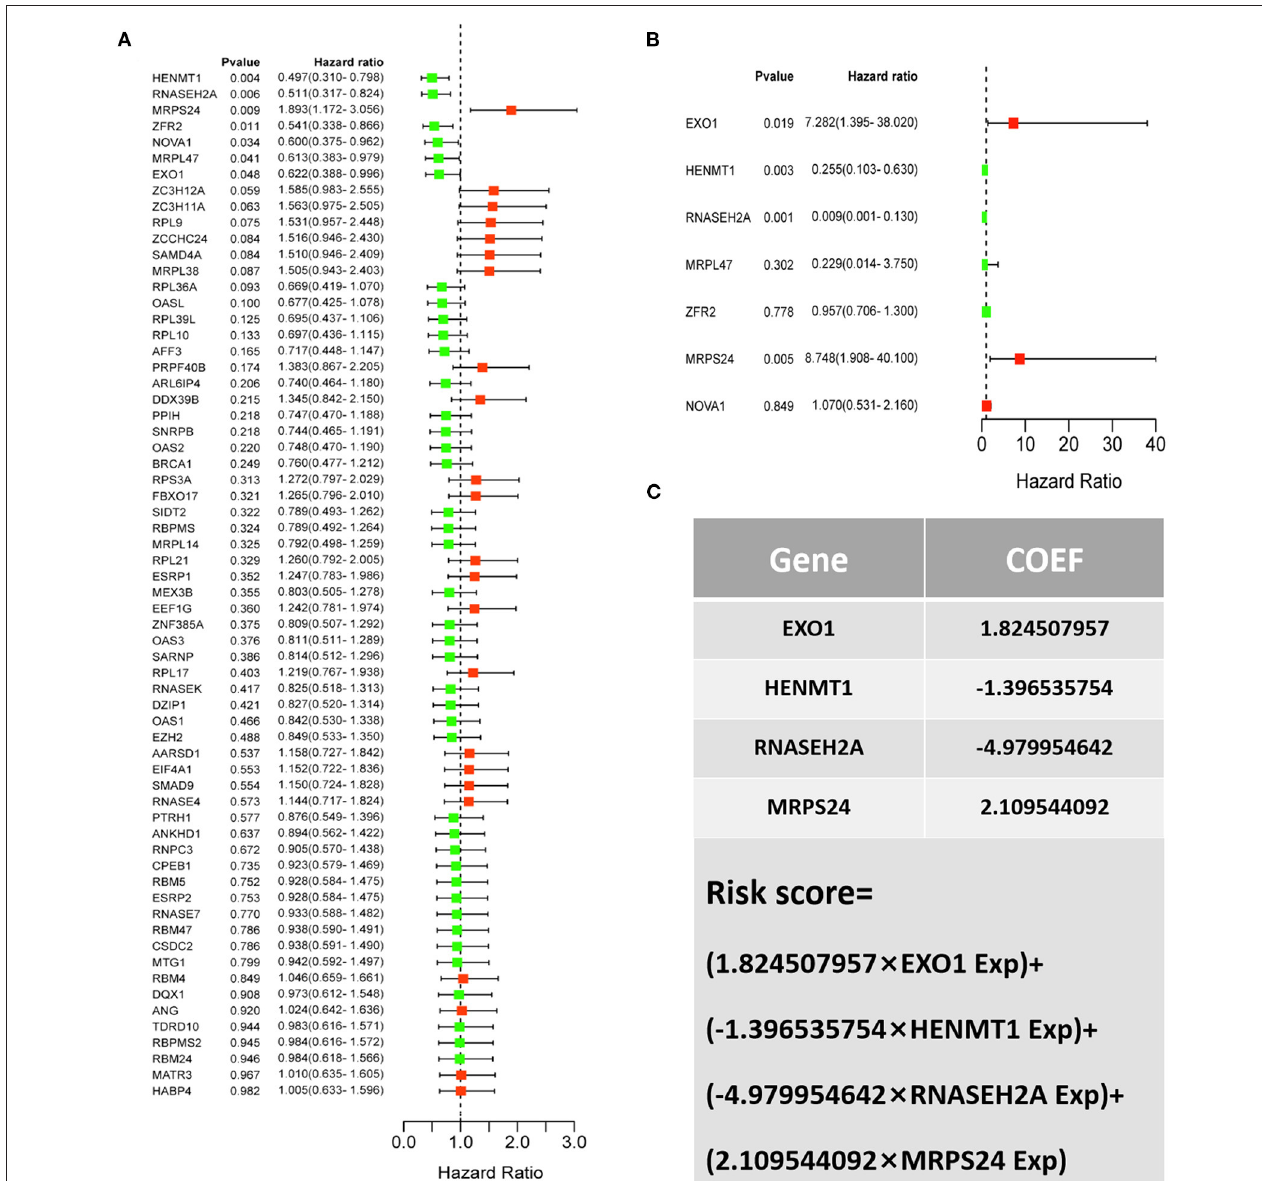
FIGURE 5 | CESC patient risk model based on prognosis related RBPs (A) Survival analysis was used to screen prognosis related RBP. (B) Multivariate prognostic analysis of seven prognosis related RBPs (EXO1, HENMT1, RNASEH2A, MRPL47, ZFR2, MRPS24 and NOVA1). (C) Calculation formula of comprehensive risk score of four genes. Exp stands for gene